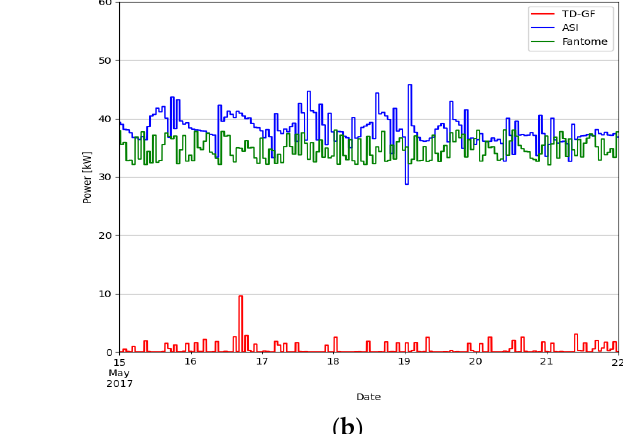
Figure 9. Power data for the Crous and AHU loads, ( a ) Training Period, ( b ) Test Period.